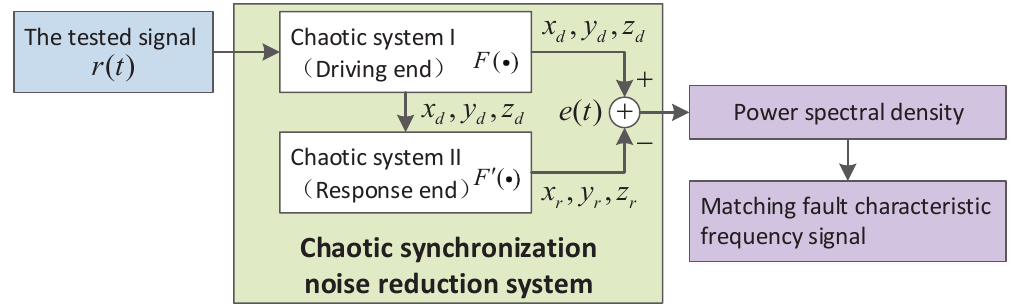
Figure 1. The principle block diagram of the detection